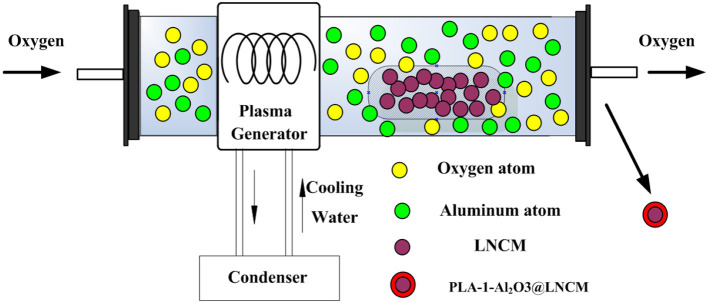
Schematic diagrams for PLA-1-Al2O3@LNCM.